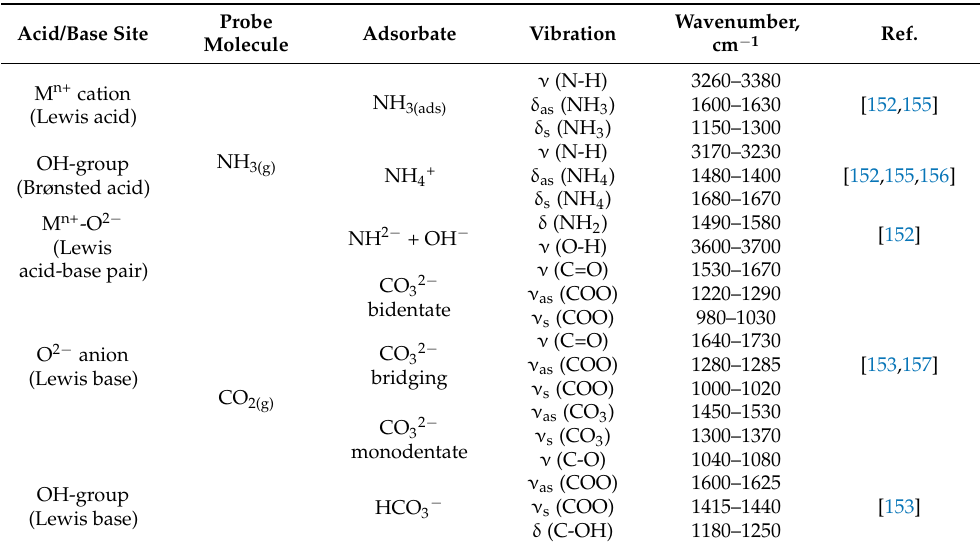
Table A1. Infrared vibrational wavenumbers of adsorbed probe molecules on acid/base sites at metal oxide